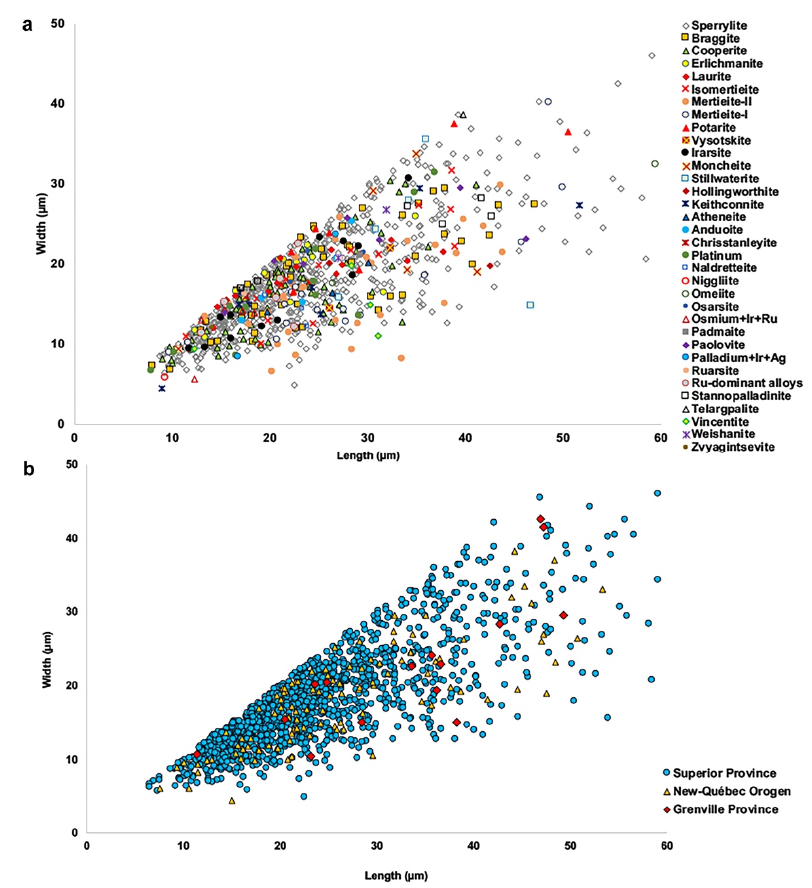
Figure 18. Grain size distribution of platinum-group minerals (PGMs) occurring in the < 50 µm heavy mineral super-concentrates from glacial till sediments. ( a ) Range of PGMs’ width vs. length measurements for the various mineral species recovered from samples collected in the James Bay territory, Archean Superior Craton (Quebec, Canada). ( b ) Range of width vs. length measurements of sperrylite grains from various geological settings within the Canadian Shield. Majority of the grains show similar size distributions regardless of their mineral species and/or sampling area.